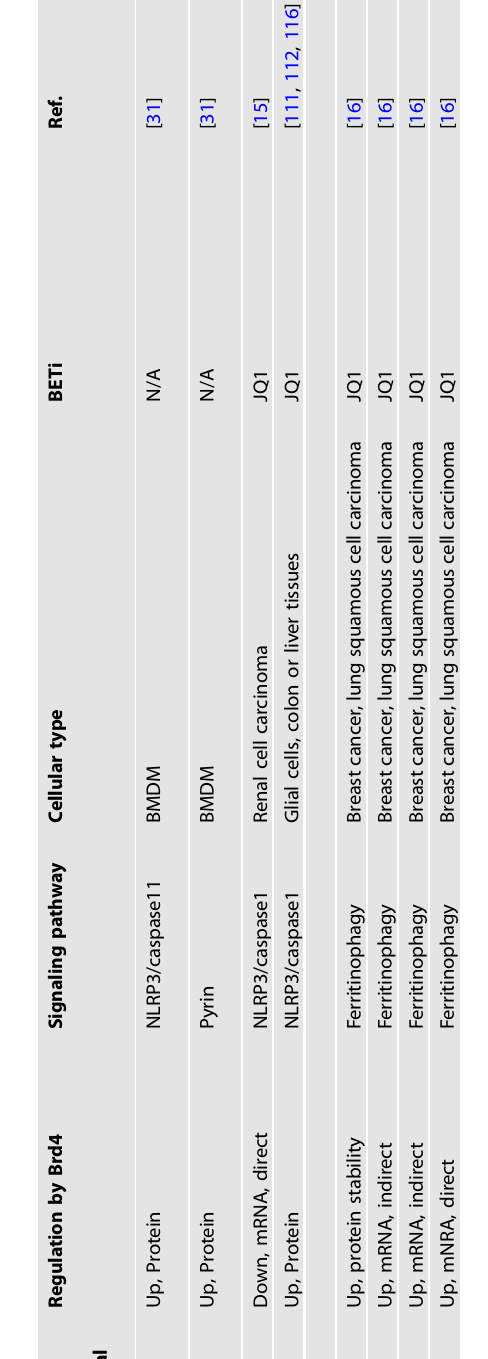
suppress their transcription although the underlying mechanisms remain undetermined [41]. Brd4 is able to suppresses gene expression by the recruitment of histone methyltransferase G9a [13, 43]. Conceivably, the interaction of Brd4 and G9a might be involved in Brd4-mediated repression of these pro-apoptotic genes. In a different study, Brd4 regulates the expression of BH3- only protein BIM via miR17 – 92, a key post-transcriptional repressor of BIM expression [44, 45]. Brd4 binds to the promoter of miR17 – 92 to facilitate its expression, which suppresses the transcription of BIM, leading to the inhibition of apoptosis [44]. Therefore, Brd4 can suppress the expression of these pro- apoptotic genes at the transcriptional and post-transcriptional levels. In addition to the intrinsic pathway, Brd4 also regulates the extrinsic pathway of apoptosis. The extrinsic apoptotic pathway is initiated by activation of cell membrane proteins known as death receptors (DRs), which include the TNF receptor 1 (TNFR1, also known as DR1), FAS (DR2, its ligand is FasL), and the TNF-related apoptosis-inducing ligand (TRAIL) receptors DR4 and DR5. Upon ligands binding, death receptors recruit adapter protein FAS- associated protein with death domain (FADD) and initiator caspases, such as caspase 8 and 10, to form the death-inducing signaling complex (DISC). Under normal situation, Caspase-8 and 10 are inactive with their interactions with cellular FLICE-like inhibitory protein (cFLIP) [46]. When cFLIP is absent, Caspase-8 and 10 are activated, triggering the activation of Caspase-3 and 7, and cell apoptosis [47]. In colorectal cancer cells, DR5 and Endoplasmic reticulum (ER) stress response genes, including C/EBP homologous protein (CHOP), are signi fi cantly induced in response to Brd4 depletion and BET inhibitors (BETi) treatment [48]. Furthermore, CHOP is found to bind to the DR5 promoter upon JQ1 treatment and knockdown of CHOP can abrogate the induction of DR5 by JQ1 [48]. The regulation mechanism of Brd4-suppressed CHOP expression is unclear. One possibility is that Brd4 might down- regulate the expression of CHOP via miR-146a, which is able to target CHOP [49]. Interestingly, the expression of miR-146a is driven by Brd4 and NF- κ B co-occupied super-enhancers [50]. Moreover, apoptosis of colorectal cancer cells induced by Brd4 knockdown or inhibition in combination with chemotherapeutic drugs, such as 5- fl uorouracil (5-FU) or oxaliplatin, is markedly suppressed with DR5 genetic deletion [48]. In lymphoma and nasopharyngeal carcinoma cells, FAS abundance is negatively correlated with the expression of LIVIN [51, 52]. LIVIN binds to heat shock factor-1 (HSF-1), the transcription factor of FAS, leading to increased ubiquitination and accelerated degradation of HSF-1 [52]. The cells expressing LIVIN are signi fi cantly resistant to FASL-induced apoptosis [51]. BET inhibitor or Brd4 degrader decreases LIVIN expression in a concentration-dependent manner [51]. Consistently, BET family proteins, such as Brd4 and Brd2, enhance transcription of BIRC7 (encodes LIVIN) via binding to its promoter/enhancer [51]. By regulating the expression of LIVIN via HSF-1, Brd4 indirectly regulates the expression of FAS and extrinsic pathway of apoptosis. LIVIN, also known as melanoma inhibitor of apoptosis protein (ML-IAP), is a member of the inhibitor of apoptosis proteins (IAPs) family that confer protection from intrinsic or extrinsic apoptosis by inhibiting caspase activation [53]. Generally, IAP family proteins characterized by a novel domain termed the baculoviral IAP repeat (BIR), comprise 8 members (BIRC1 – 8), including NAIP/ BIRC1 , cIAP1/ BIRC2 , cIAP2/ BIRC3 , XIAP/ BIRC4 , Survivin/ BIRC5 , Apollon/ BIRC6 , ML-IAP/ BIRC7 and ILP2/ BIRC8 [53]. The activation or activity of both initiator and executioner caspases can be regulated by IAPs